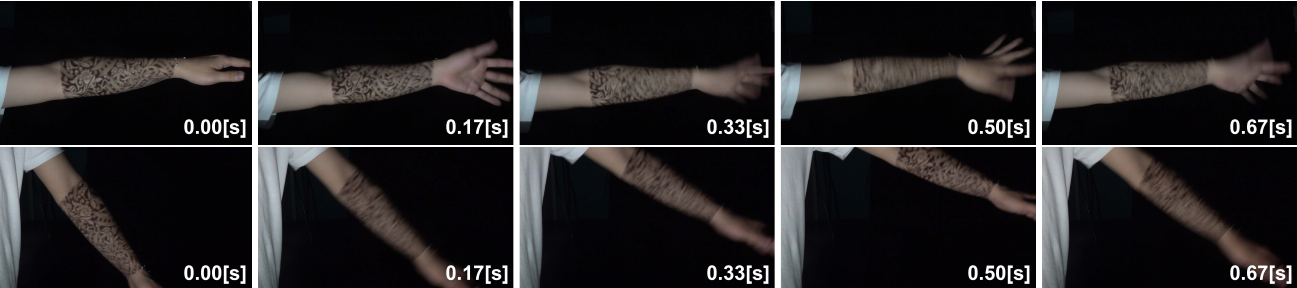
Figure 7. Projection of tattoo images on the forearm. The user can hardly perceive any misalignment between the projected image and the arm even during high-speed rotations (first row) and translations (second